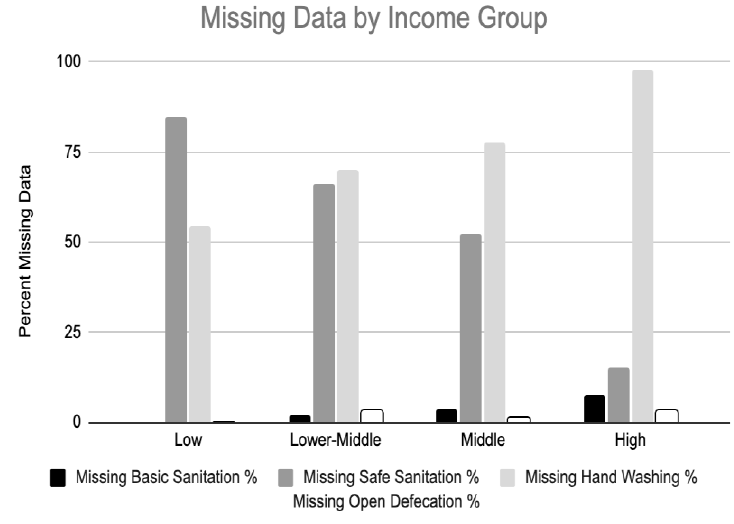
Figure 3. Missing Data by Development.